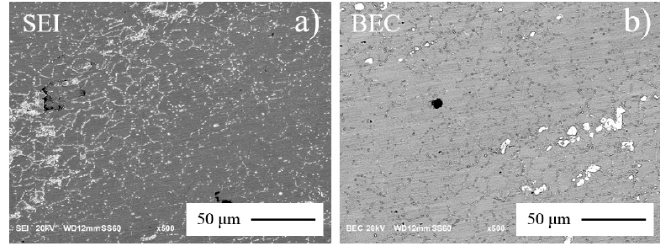
Figure 11. SEM micrographs of annealed Inconel 718 after ( R = − 1, f = 20 kHz, σ a = 400 MPa, Nf > 1 × 10 9 cycles): ( a ) SEI mode; ( b ) BEC mode.